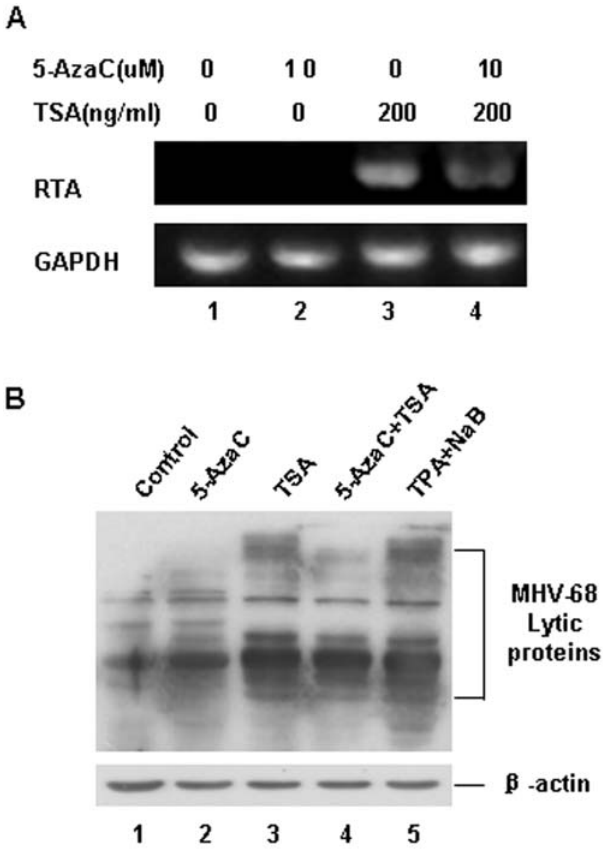
Figure 6. TSA and 5-AzaC did not act synergistically to induce MHV-68 reactivation. (A) RT-PCR analysis of MHV-68 RTA mRNA expression after 5-AzaC and/or TSA treatment. S11E cells were induced with 5-AzaC (10 m M) and/or TSA (200 ng/ml) for 24 hrs and then total RNA were isolated for RT-PCR, GAPDH mRNA was amplified as a control. (B) Western blotting analysis of MHV-68 lytic protein expression after 5- AzaC and/or TSA treatment. TPA (25 ng/ml) plus NaB (4 mM) treatment served as a positive